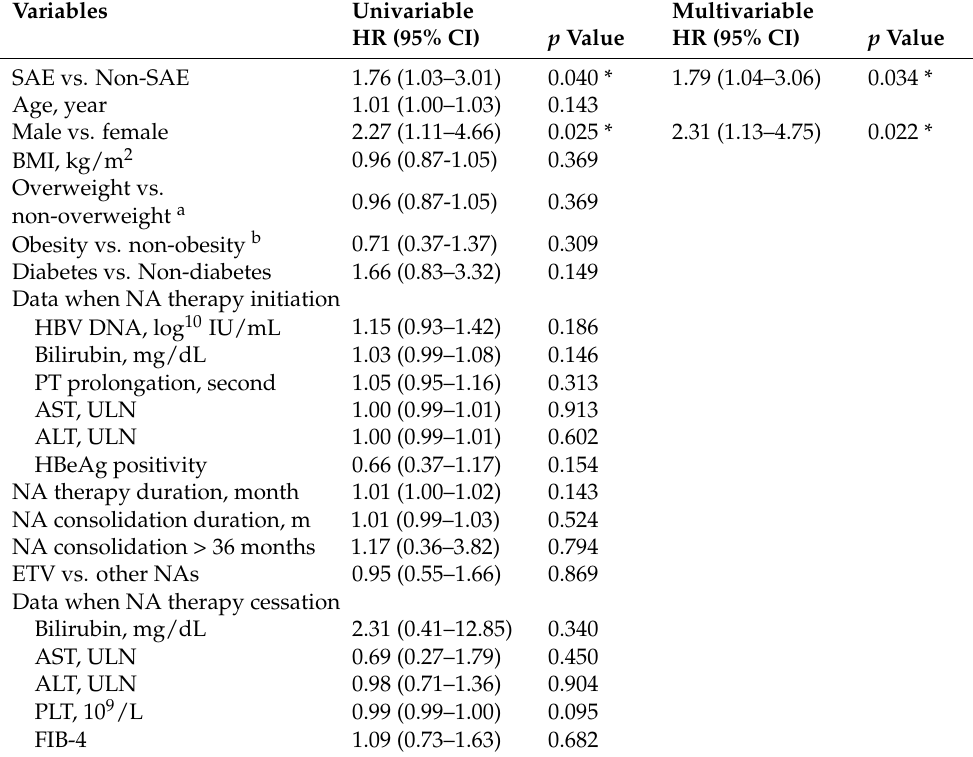
Table 2. Cox proportional hazards regression model analysis for severe clinical